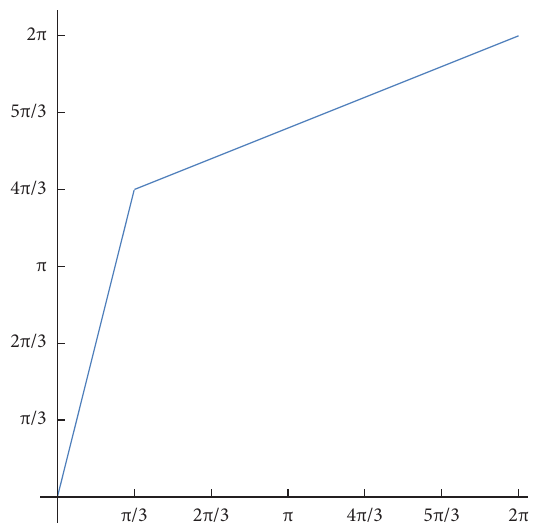
Figure 5: Plot of function ϕ in equation (33) in Example